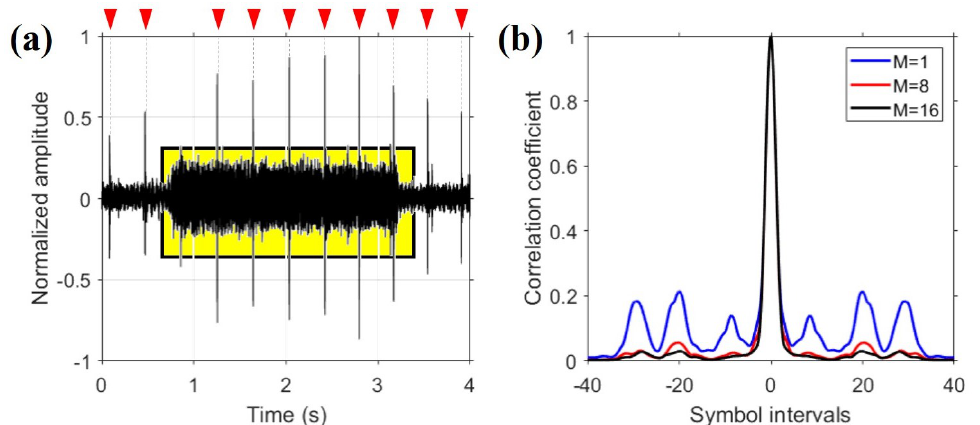
Figure 7. ( a ) Signal obtained by one receiver. The click sounds captured during the experiment are identified by red arrows. ( b ) Averaged Q-function as a function of the order of spatial diversity. The blue, red, and black lines correspond to orders of spatial diversity ( M ) of 1, 8, and 16, respectively. As the order of diversity increases, the sidelobes become smaller, i.e., the Q-function converges to the delta function.